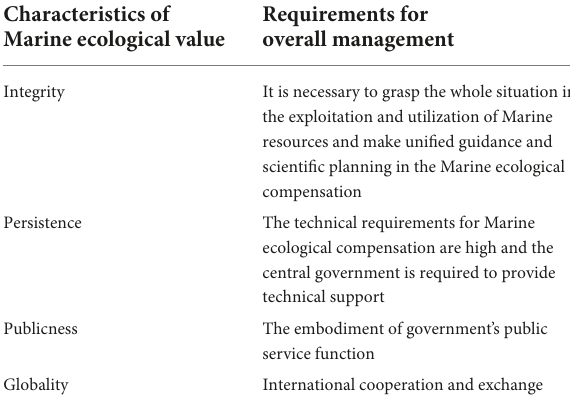
TABLE 6 The corresponding relationship between the characteristics of Marine ecological value and the requirements of Marine ecological compensation for overall